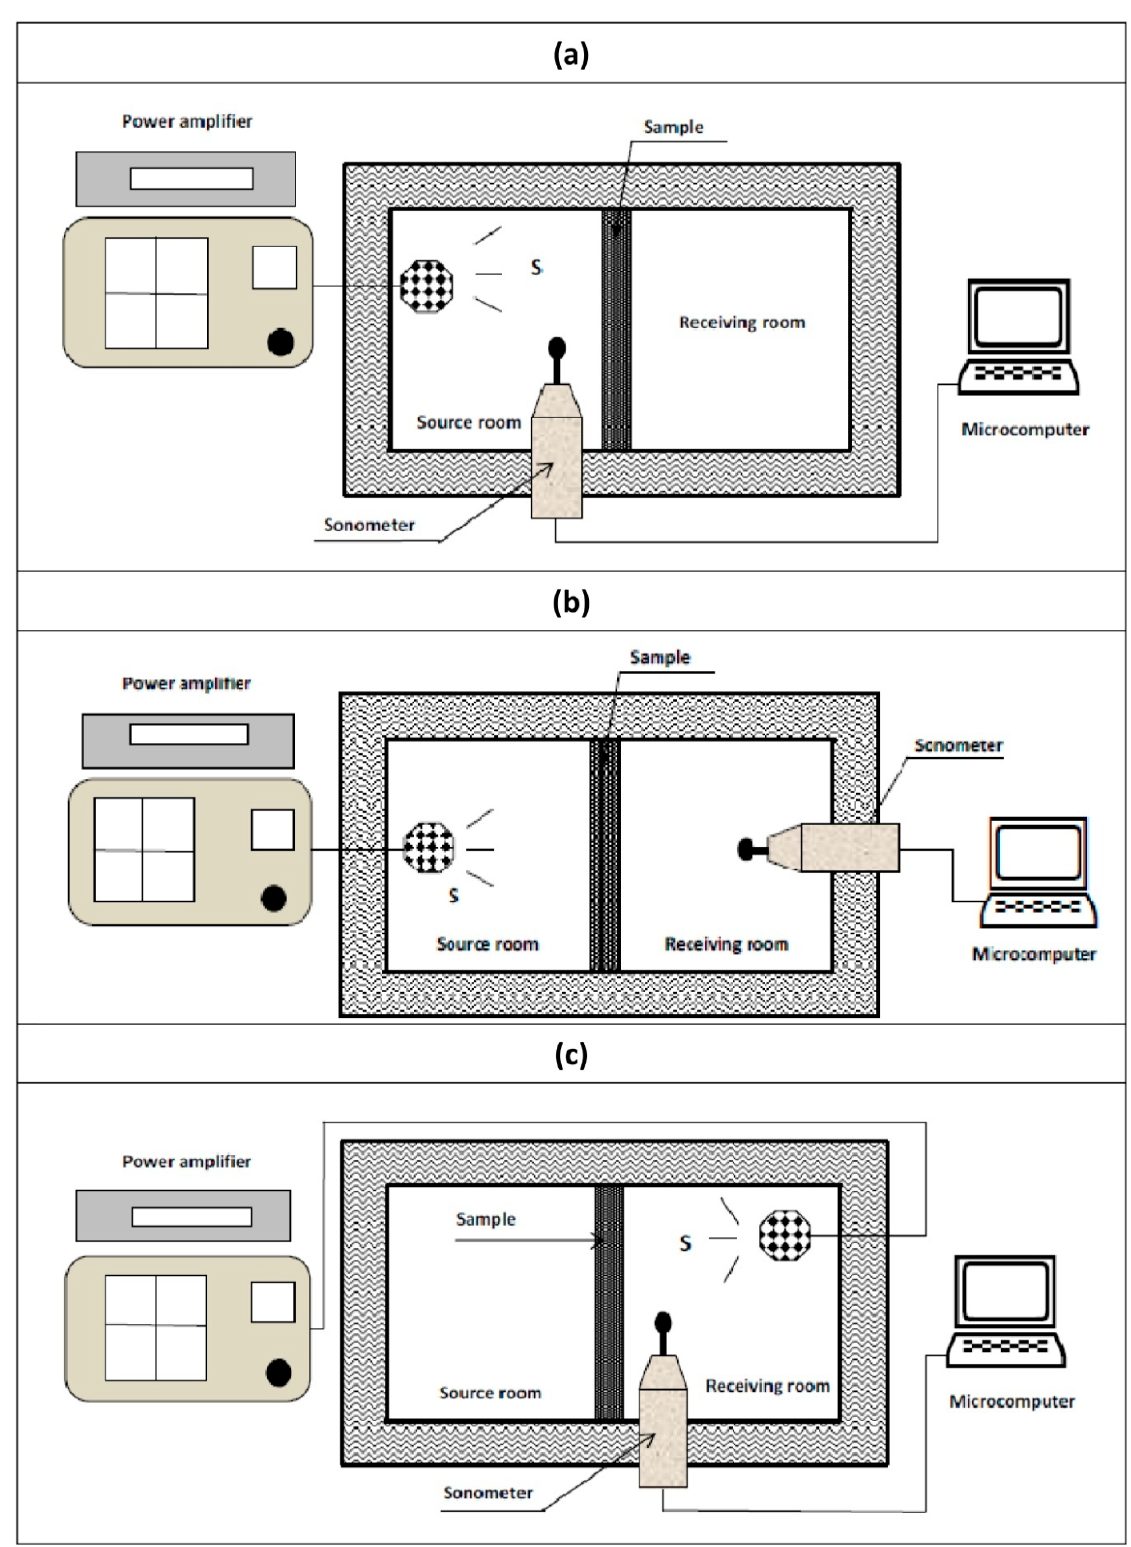
Figure 6. Measurement device: ( a ) measurement of L 1 in the source room, ( b ) measurement of L 2 in the receiving room and ( c ) measurement of the reverberation time T r60.